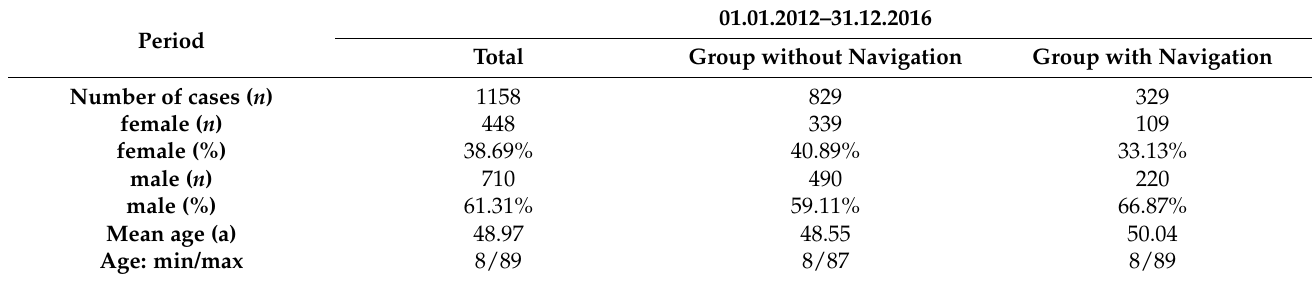
Table 1. Characterization of the total